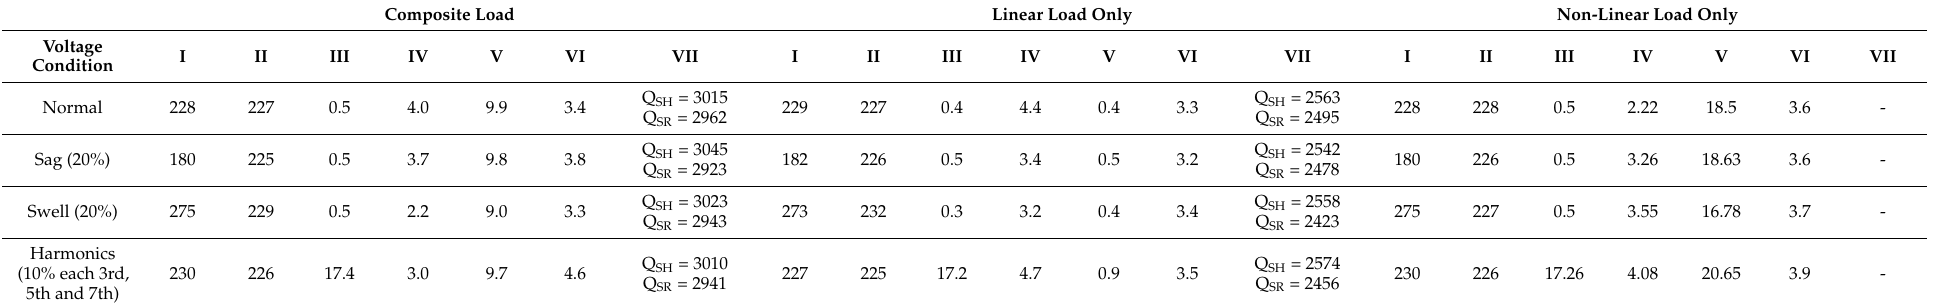
Table 2. Performance parameters under different source voltage and loading